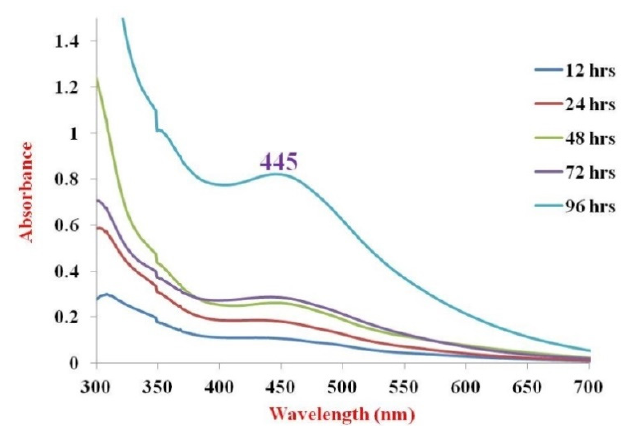
Figure 2. UV–Vis spectroscopy of intense SPR spectra at 445 nm. The maximum absorbance was noticed with increased incubation time (up to 96 hrs).